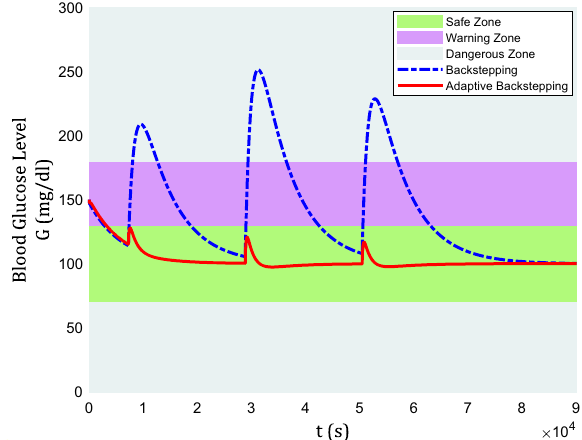
Figure 7. Blood glucose level in the presence of actuator faults under the control algorithm.